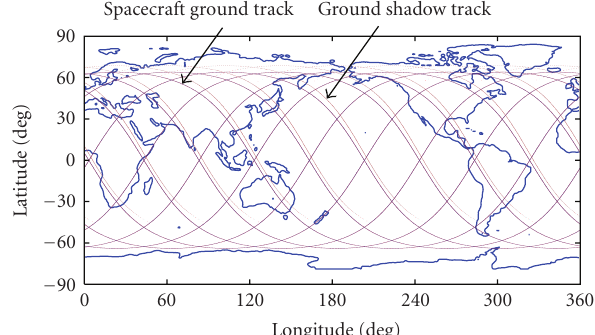
Figure 16: The spacecraft ground track and the ground shadow track for an RSTO.